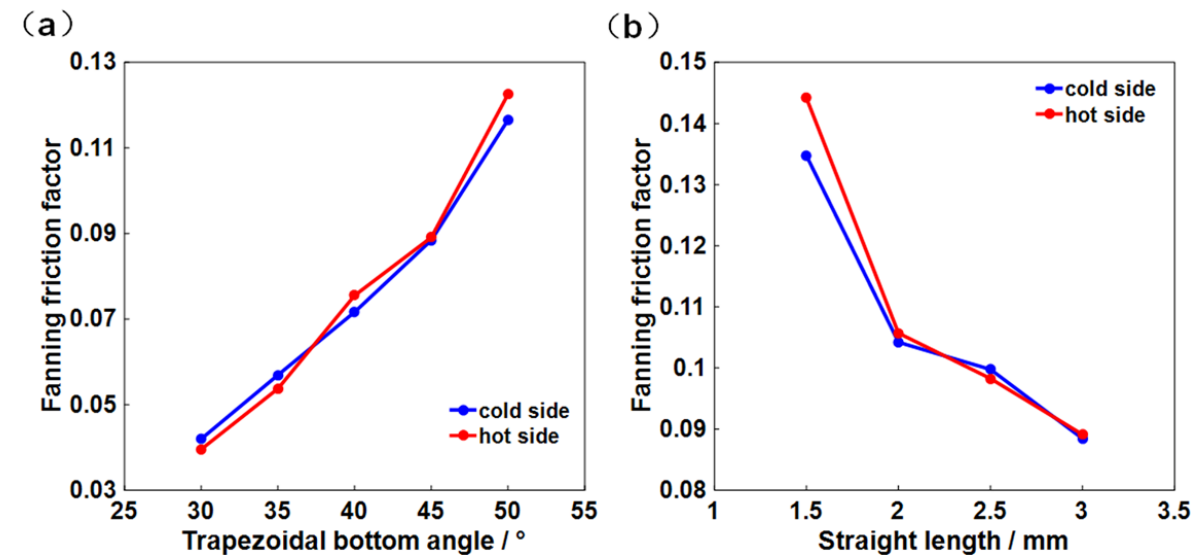
Figure 4. Effects of ( a ) the trapezoidal bottom angle and ( b ) the straight length on the Fanning factors.